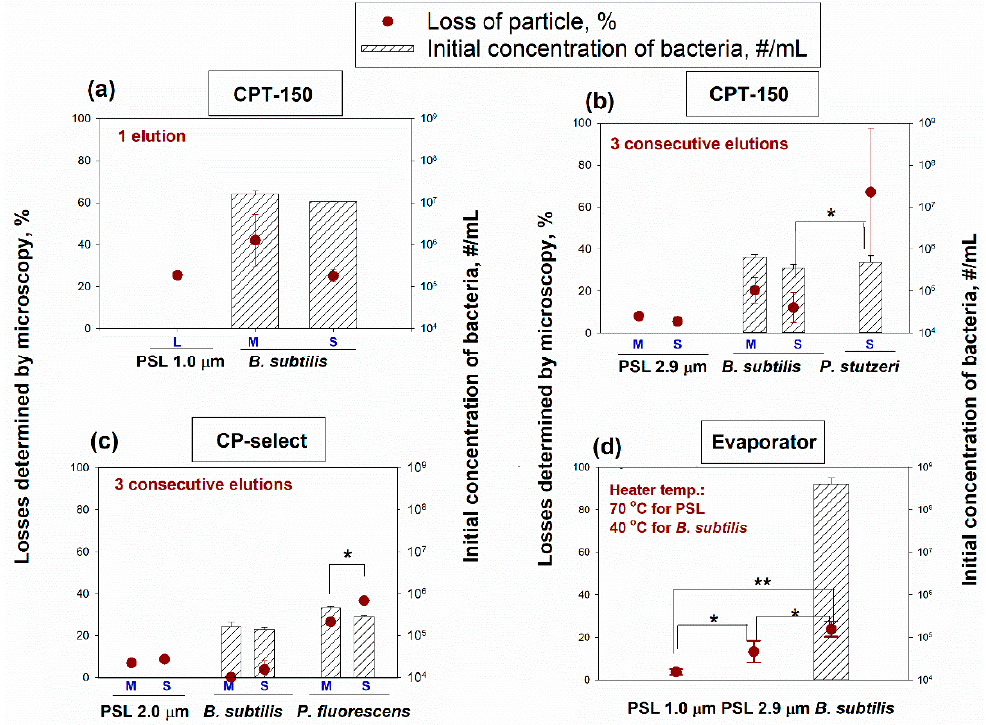
Figure 4. Losses (%) of particles as quantified by microscopy when using the two types of concentrating devices: the CP-150 ( a , b ) and the CP-Select ( c ) with di ff erent elution fluid volumes (L: Large, M: Medium and S: Small) with three consecutive elutions and with one and three consecutive elutions for the CP-150. ( d ) presents the losses by the Evaporator for the three di ff erent PSL particle sizes (i.e., 1.0, 2.0 and 2.9 μ m, with 1% solids in suspension) and bacterial cells ( B. subtilis , P. fluorescens and P. stutzeri ). The data represent the averages of three repeated measurements. The error bars represent one standard deviation. * p < 0.05, ** p < 0.001, and p values are based on multiple pairwise comparisons using the Holm–Sidak method, and p values are analyzed by one ‐ way ANOVA.